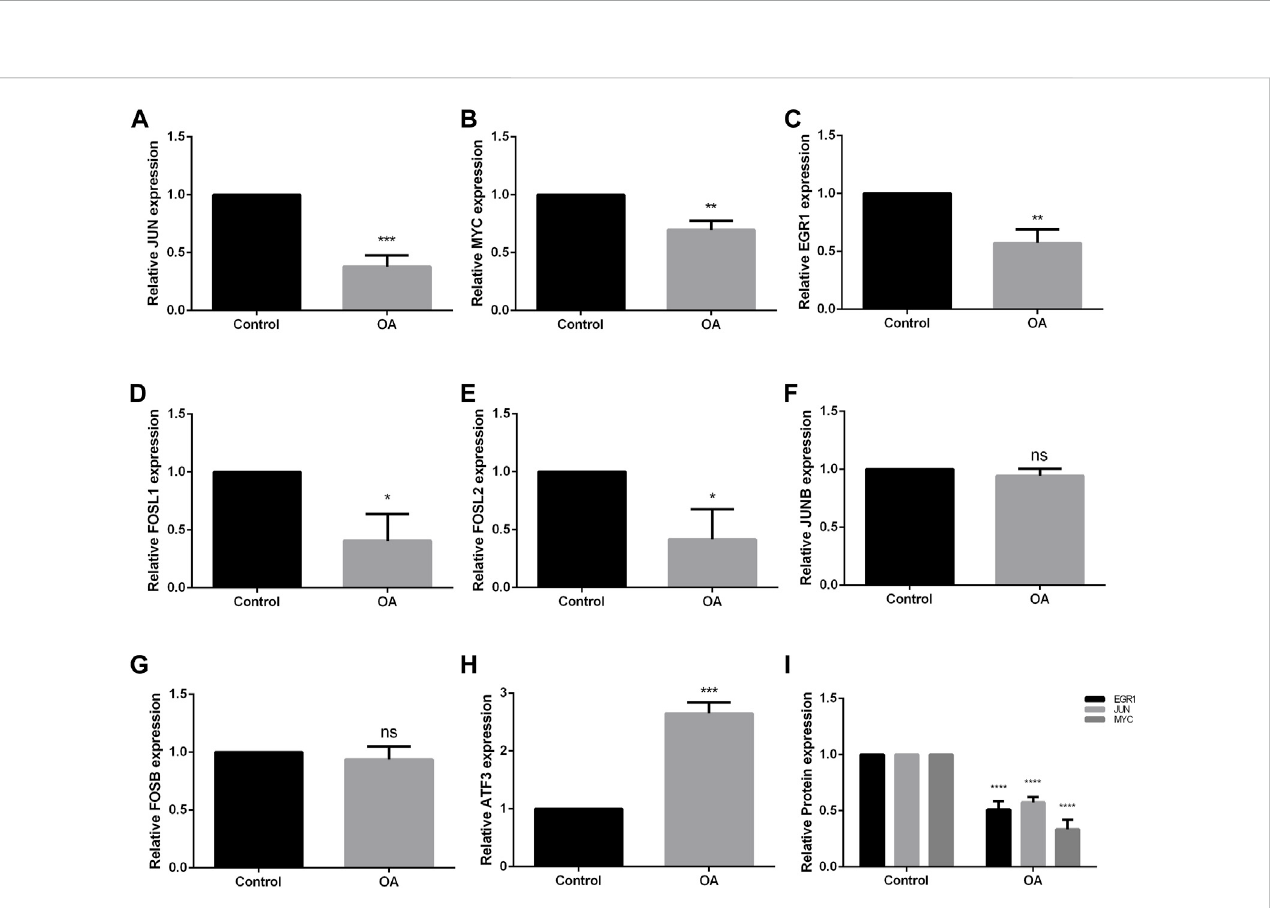
FIGURE 7 Validation of hub genes through qRT-PCR and ELISA of FLS. (A – H) mRNA expression of JUN, MYC, EGR1, FOSL2, FOSL1, JUNB, FOSB and ATF3. JUN, MYC,EGR1,FOSL2andFOSL1showedthesametrendastheresultsofbioinformaticsanalysis.JUNBandFOSBshowednosigni fi cantdifferencebetweentwo groups, while MYC showed the opposite trend. (I) The result of ELISA analysis of EGR1, JUN and MYC in the supernatant of FLS. OA = osteoarthritis. * p < 0.05, ** p < 0.01, *** p < 0.001, **** p < 0.0001. Error bars represent